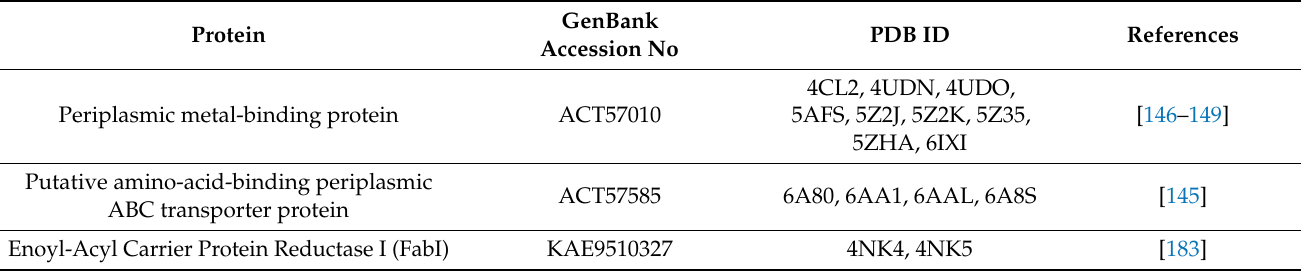
Table 6. Crystal structure of important protein from C